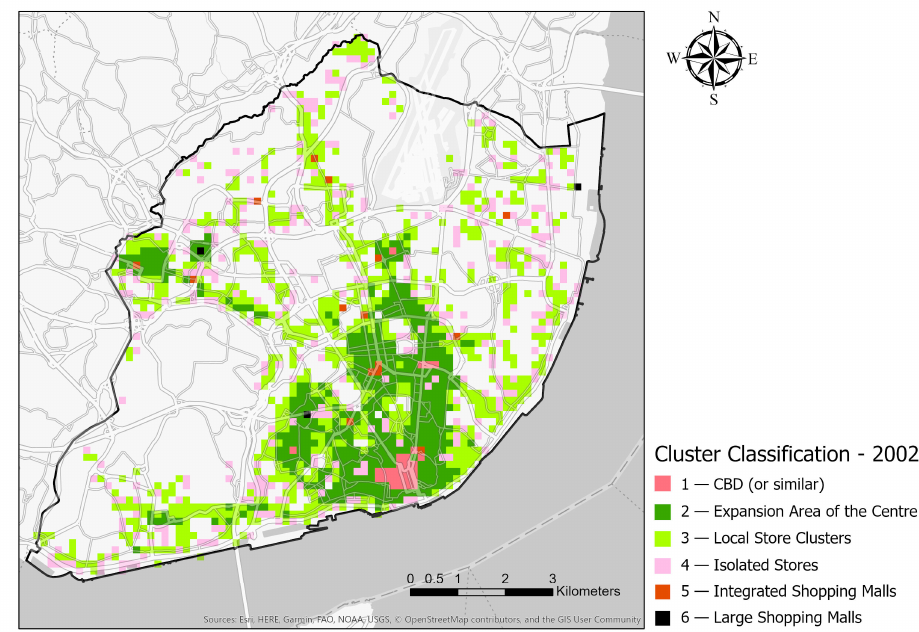
Figure 3. Cluster Classification—2002.